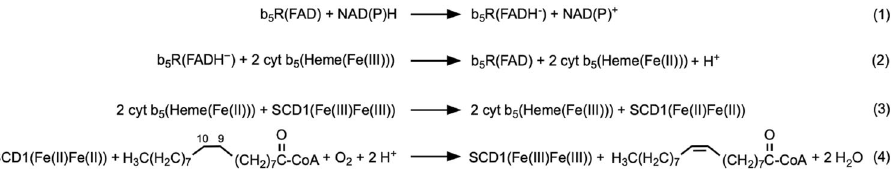
Fig. 1 Stepwise reactions in the electron transport chain of b 5 R, cyt b 5 , and SCD1. The redox states of cofactors in proteins are indicated in the